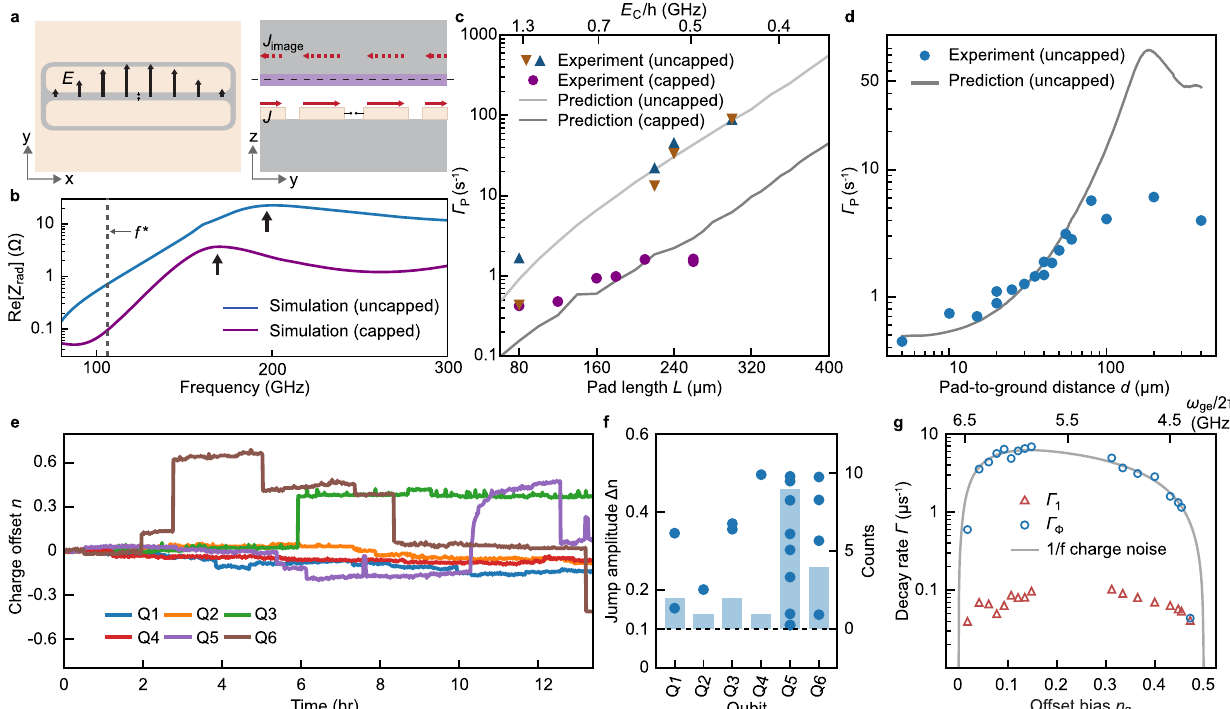
Fig. 3 | Effect of circuit geometry on parity switching, charge offset stability, and coherence. a Top view of the electric fi eld ( E , arrows) of the fundamental radiation mode formed by the fl oating transmon structure (left). Mode current ( J , solid arrows) and its image ( J image , dashed arrows) on the two sides of the alumi- nium cap indicated by the dashed line (right). b Real part of the simulated input impedance Z rad of a typical qubit ( L =260 μ m, W =35 μ m) with and without a cap. The arrows indicate the peaks corresponding to the fundamental mode. The dashed line indicates the superconducting gap frequency at 105GHz. c Measured parity switching rates for capped (dots) and uncapped (triangles) qubits with varying pad size plotted as a function of the pad length. In the uncapped case, the pad width is also varying, but the effect is much smaller. The solid lines indicate fi nite-elementsimulationpredictions.Thetopaxisindicatesthechargingenergy E